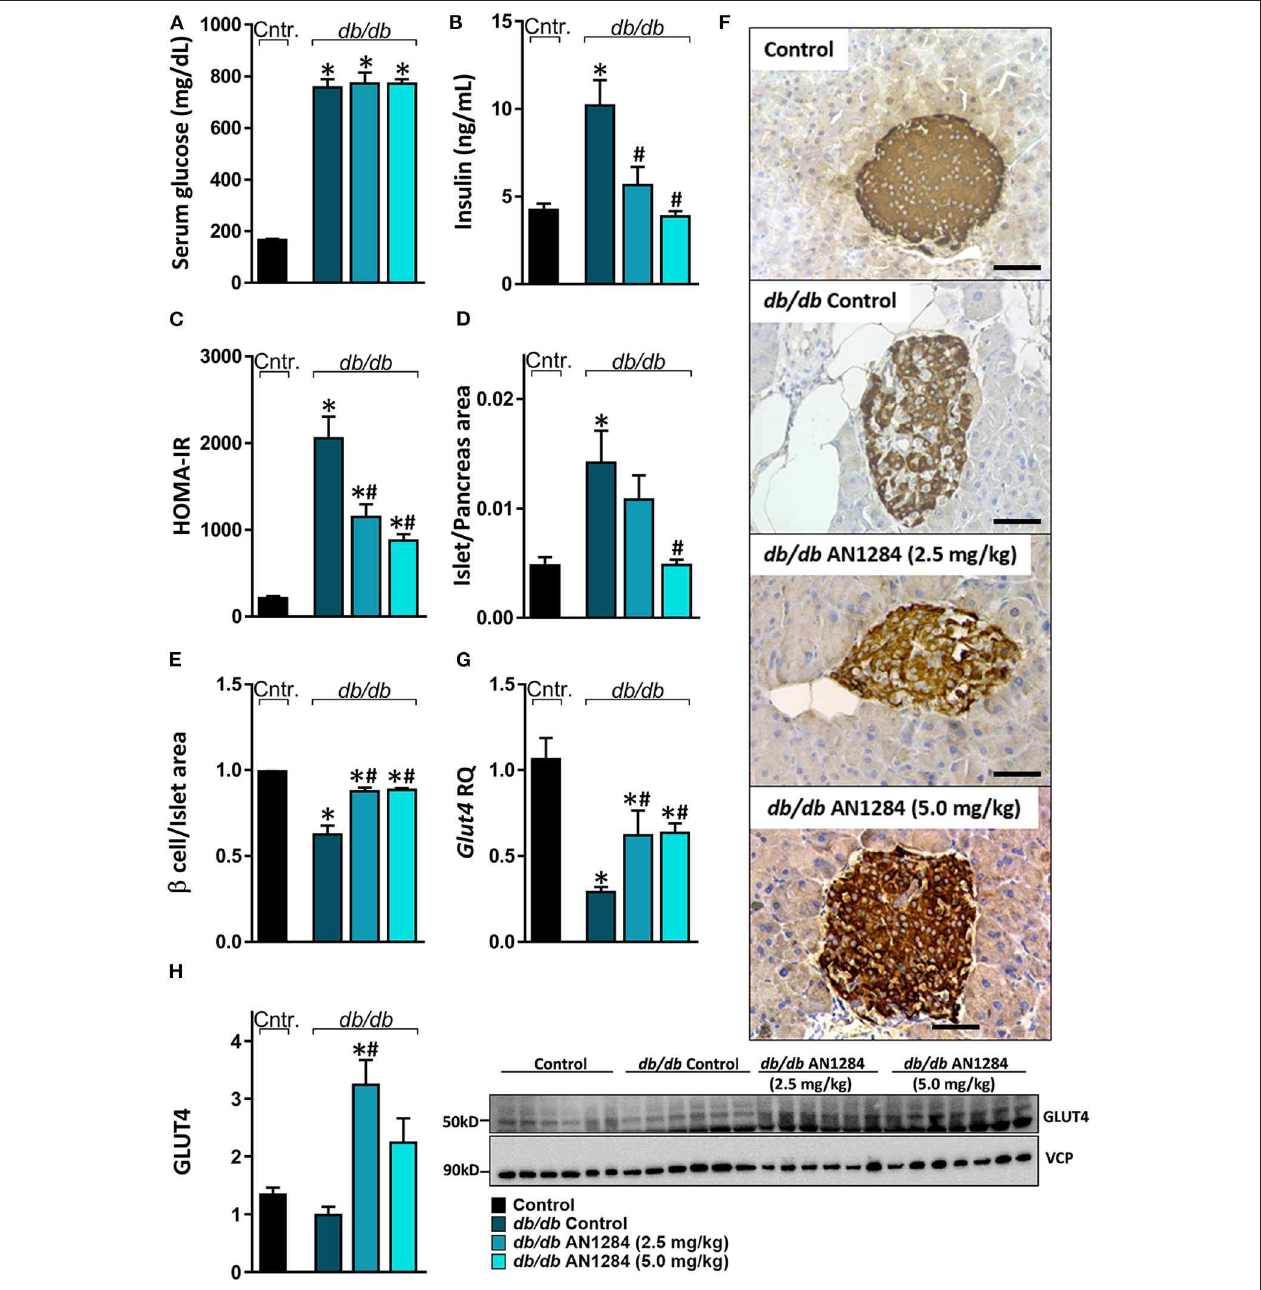
FIGURE 5 | AN1284 increases insulin sensitivity in db/db mice. The db/db mice exhibit hyperglycemia and hyperinsulinemia ( A,B , respectively), compared with healthy controls. AN1284 treatment significantly reduced serum insulin levels without changing those of serum glucose. A reduced HOMA-IR (C) and Langerhans islet-to-pancreas tissue ratio (D) , and an increased β cell-to-Langerhans islet area (E) and Glut4 mRNA (G) as well as protein expression (H) were found in db/db mice treated with AN1284. (F) Representative insulin staining of the pancreas from each treatment group. Original magnification, × 40. Scale bar, 50mm. Data represent the mean ± SEM from 8 to 10 mice per group. * P < 0.05 relative to control non-diabetic mice, # P < 0.05 relative to db/db -Veh-treated control mice.